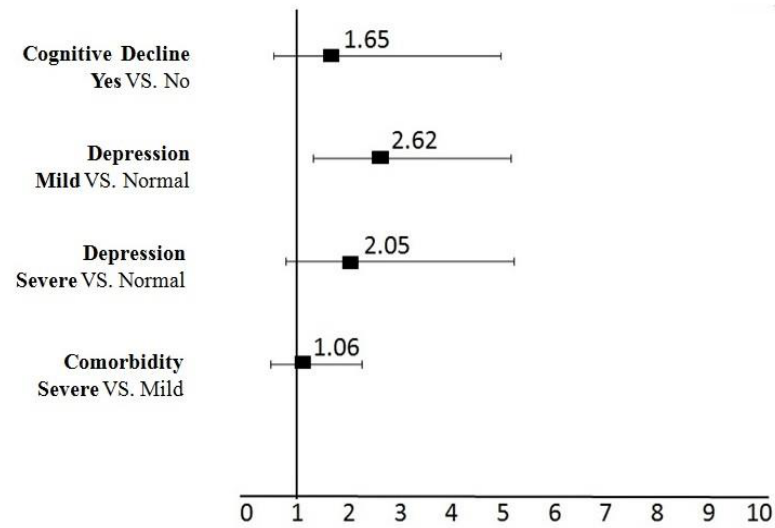
Figure 2. The impact of geriatrics Syndromes on Frailty (Multi-variate model analysis). Adjusting OR for gender, age, annual individual income, smoking, and educational level. Notes: An OR > 1 indicates a greater likelihood of elders having (Yes, Mild, Severe, VS., etc.) to be frail. Bars represent 95% (CI). Abbreviations: OR, odds ratio.